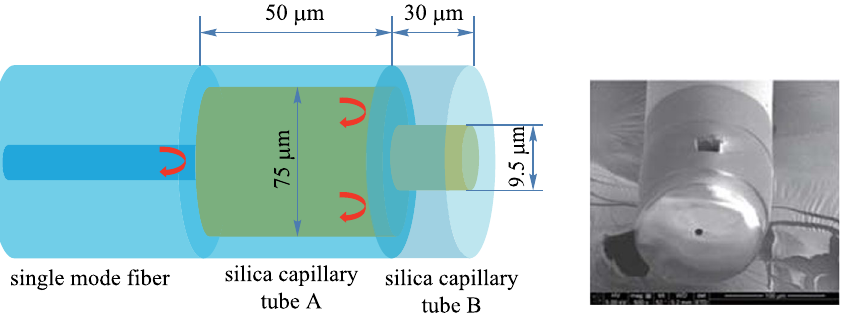
Fig. 8 Open cavity Fabry−Perot interferometer based on optical fiber for magnetized field sensing [36]. Copyright 2017, IEEE Xplore. Repro- duction with permission